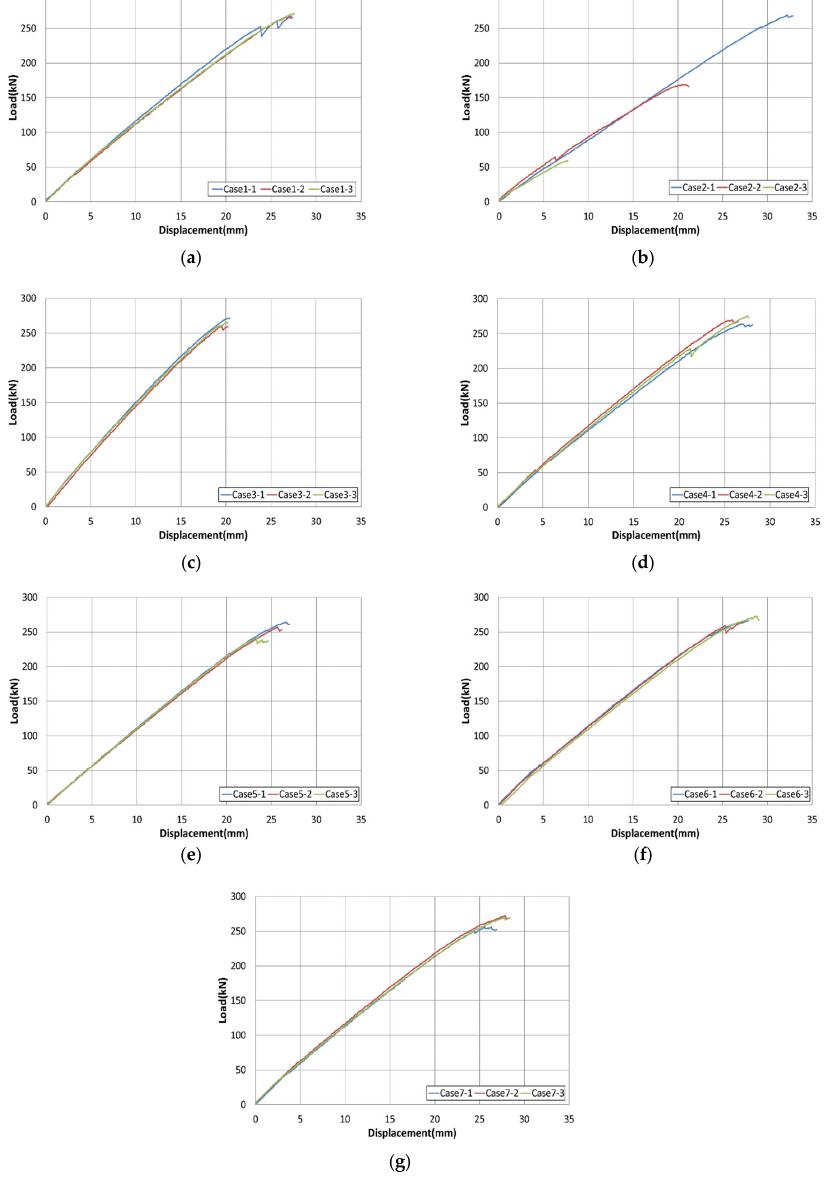
Figure 9. Load–displacement graphs used for the assessment of bond performance improvements: Cases ( a ) 1, ( b ) 2, ( c ) 3, ( d ) 4, ( e ) 5, ( f ) 6, and ( g ) 7.